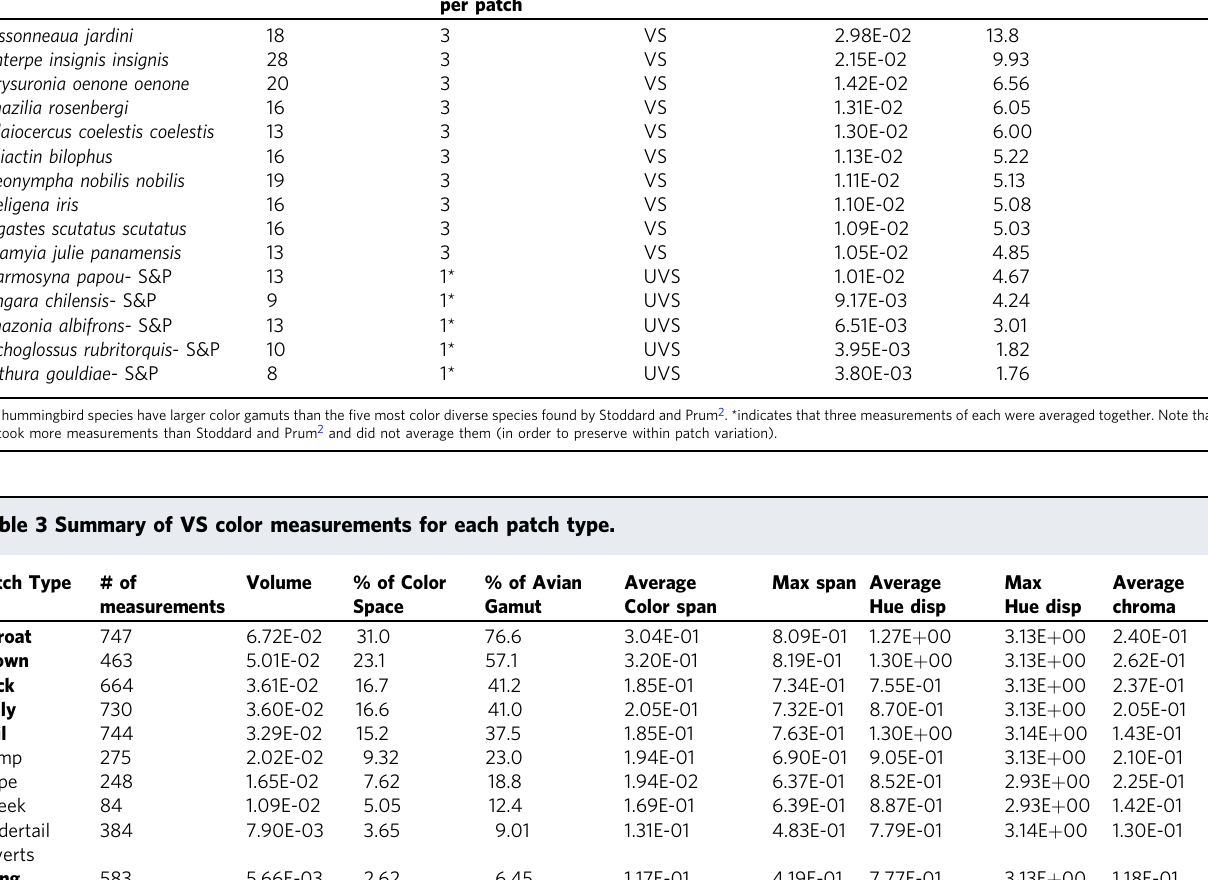
Color System per patch